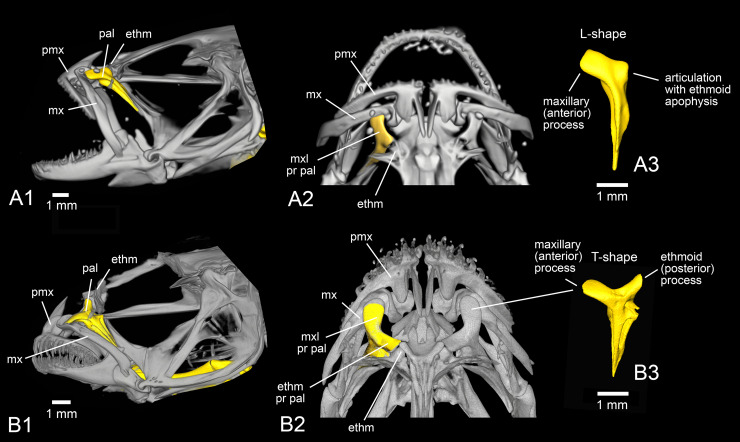
Anatomical position and details of the palatine (yellow) of extant gobioid species.(A) Eleotris pisonis (ZSM 9393), skull in lateral (A1) and dorsal (A2) views, left palatine (A3) in lateral view. (B) Gobius incognitus (NMP6V 146150), skull in lateral (B1) and dorsal (B2) views, left palatine (B3) in lateral view. All images based on μ-CT scanning. Abbreviations: ethm, ethmoid; ethm pr pal, ethmoid process of palatine; mx, maxilla; mxl pr pal, maxillary process of palatine; pal, palatine; pmx, premaxilla.